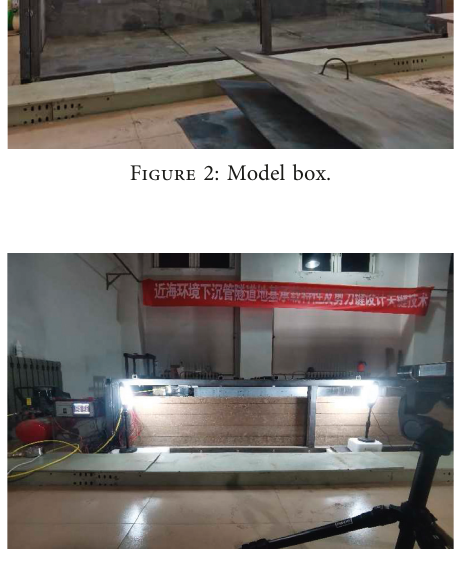
Figure 3: Monitoring of the deformed image.